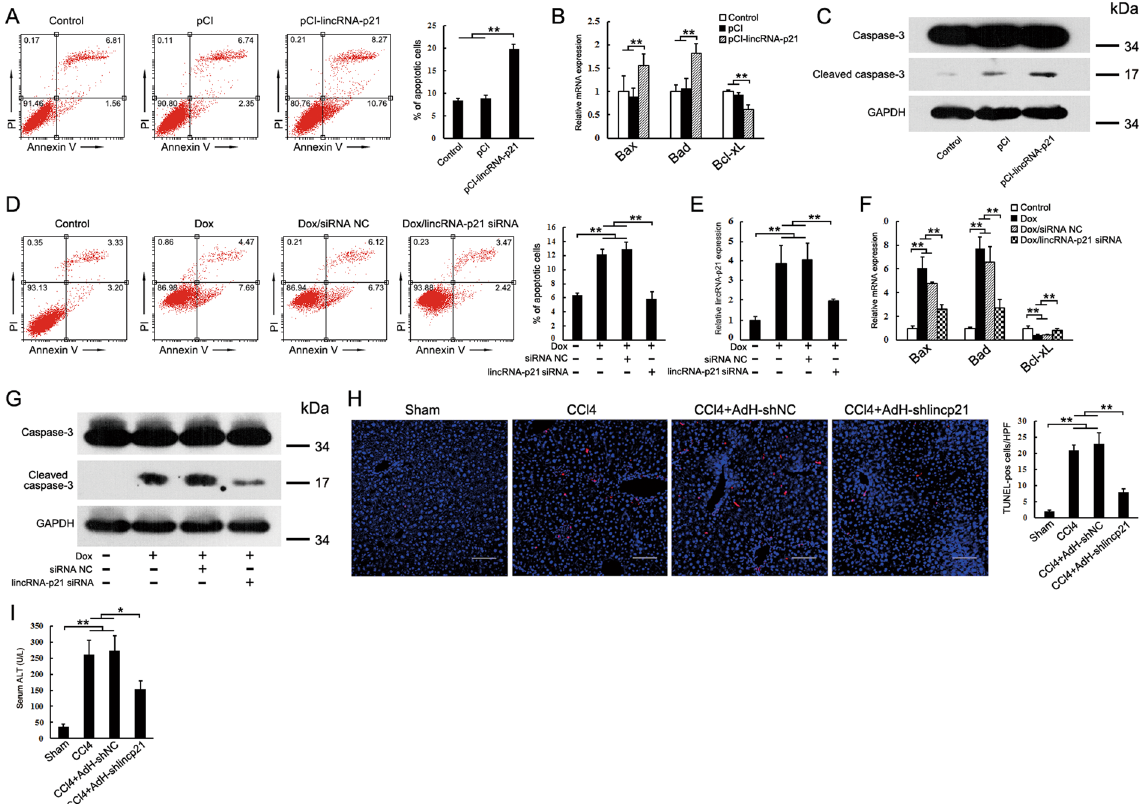
Figure 8. LincRNA-p21 promotes hepatocyte apoptosis. ( A ) Ectopic expression of lincRNA-p21 promotes hepatocyte apoptosis. AML12 cells were transfected with pCI-lincRNA-p21 for 48 h. Cell apoptosis was determined by FACS analysis. ( B ) Effects of lincRNA-p21 on Bax, Bad and Bcl-XL expression in AML12 cells. ( C ) lincRNA-p21 promotes caspase-3 cleavage. Caspase-3 and cleaved caspase-3 were detected by western blot. ( D ) Knockdown of lincRNA-p21 inhibits doxorubicin-induced hepatocyte apoptosis. AML12 cells were transfected with lincRNA-p21 siRNA for 48 h in the presence of 0.8 μ g/ml doxorubicin. ( E ) lincRNA-p21 siRNA inhibits doxorubicin-induced upregulation of lincRNA-p21. ( F ) Effects of lincRNA-p21 siRNA on doxorubicin- induced deregulation of Bax, Bad and Bcl-XL. ( G ) Knockdown of lincRNA-p21 inhibits caspase-3 activation. ( H ) Knockdown of lincRNA-p21 inhibits hepatocyte apoptosis in the CCl 4 -induced fibrotic livers. Apoptotic hepatocytes were evaluated by TUNEL staining (left) and its quantification (right). Scale bar, 50 μ m. ( I ) Knockdown of lincRNA-p21 decreased serum ALT in the CCl 4 -treated mice. qRT-PCR results are shown as fold change compared with control group. Data are the mean ± SEM of three independent experiments. * P < 0.05, ** P < 0.01. The original immunoblot images are shown in Supplementary Figure